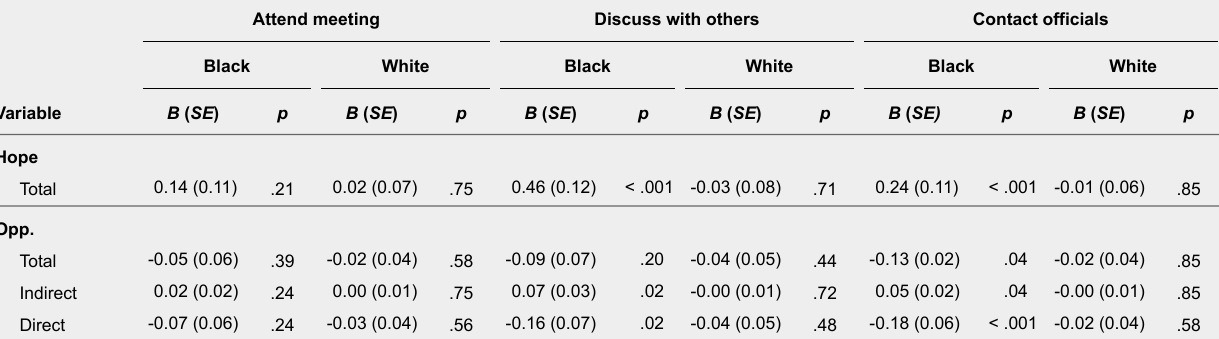
Structural Parameter Models – Total and Indirect Effects of Opportunity Treatment and Hope on Prospective DWSD Action Likelihood,